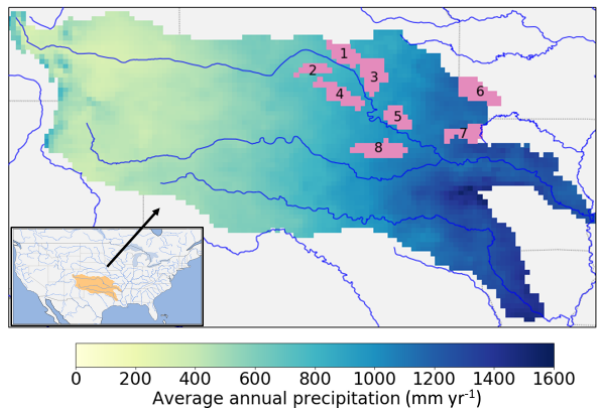
Figure 2. The Arkansas–Red River basin with climatology- averaged annual precipitation (calculated from NLDAS-2 precipi- tation data over 1979–2017). The pink shaded areas show the up- stream sub-basins of the eight USGS streamflow sites evaluated in this study, with basin numbers labeled on the plot (see Table 1 for basin numbers and corresponding